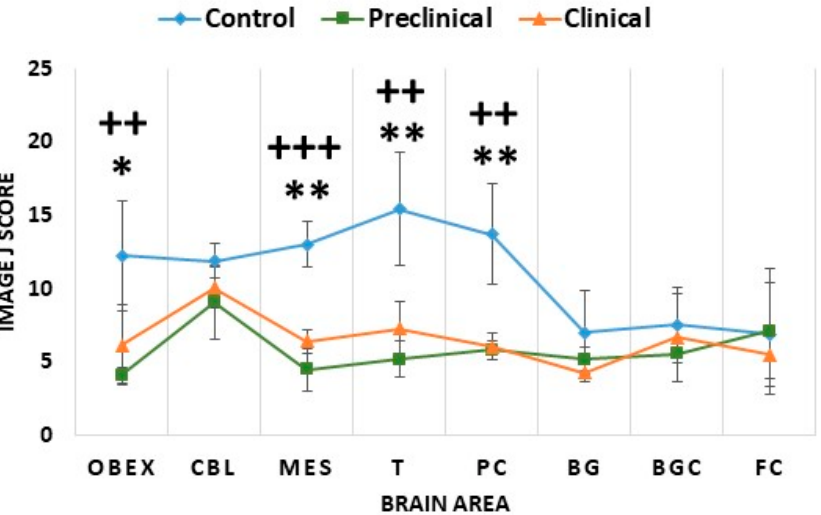
Figure 9. Immunostaining determination of 5mC in mesencephalon and thalamus of preclinical, clinical, and control sheep.